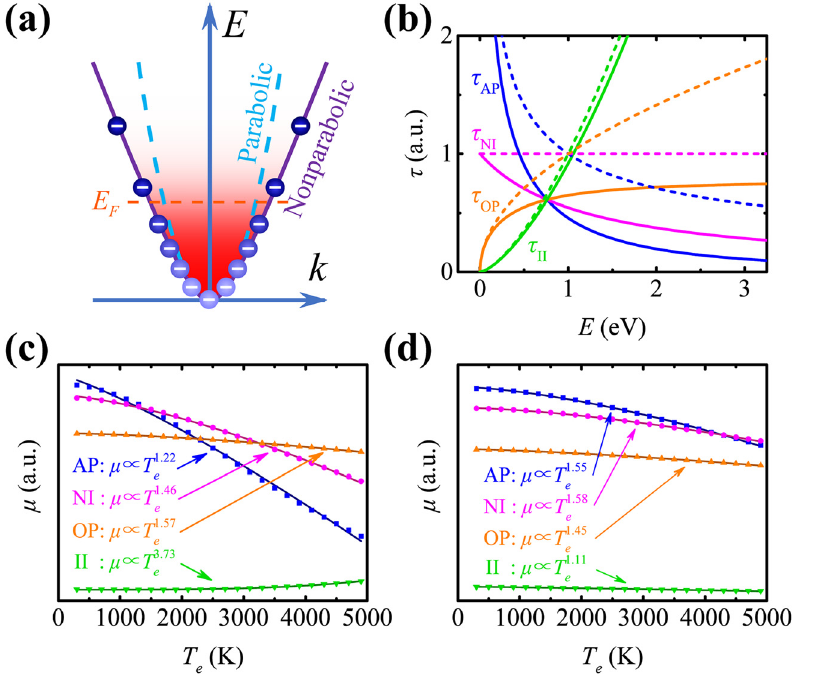
Figure 1: Simulation results. (a) Schematic diagram of electron distribution in a nonparabolic conduction band. The red color scale represents the distribution probability. (b) Electron energy – dependent scattering times of different mechanisms in parabolic ( C = 0, dashed lines) and nonparabolic ( C = 0.4191 eV − 1 , solid lines) bands. Calculated T e -dependent μ relations and the fi tting power functions for different scattering mechanisms dominant in parabolic (c) and nonparabolic (d) bands. N (cid:1) 1 . 3 × 10 21 cm − 3 and m ∗ (cid:1) 0 . 2893 m e are 0 used in the